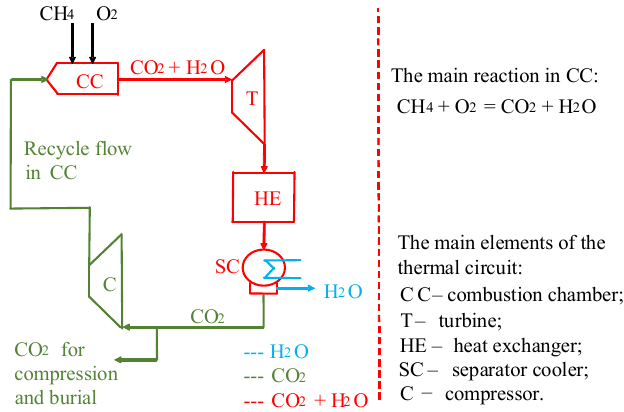
Figure 6. Schematic diagram of the oxy-fuel energy complex.